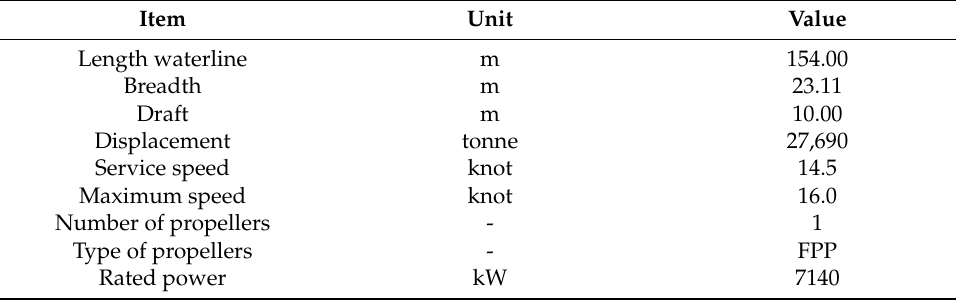
Table 1. Main characteristics of the bulk carrier.